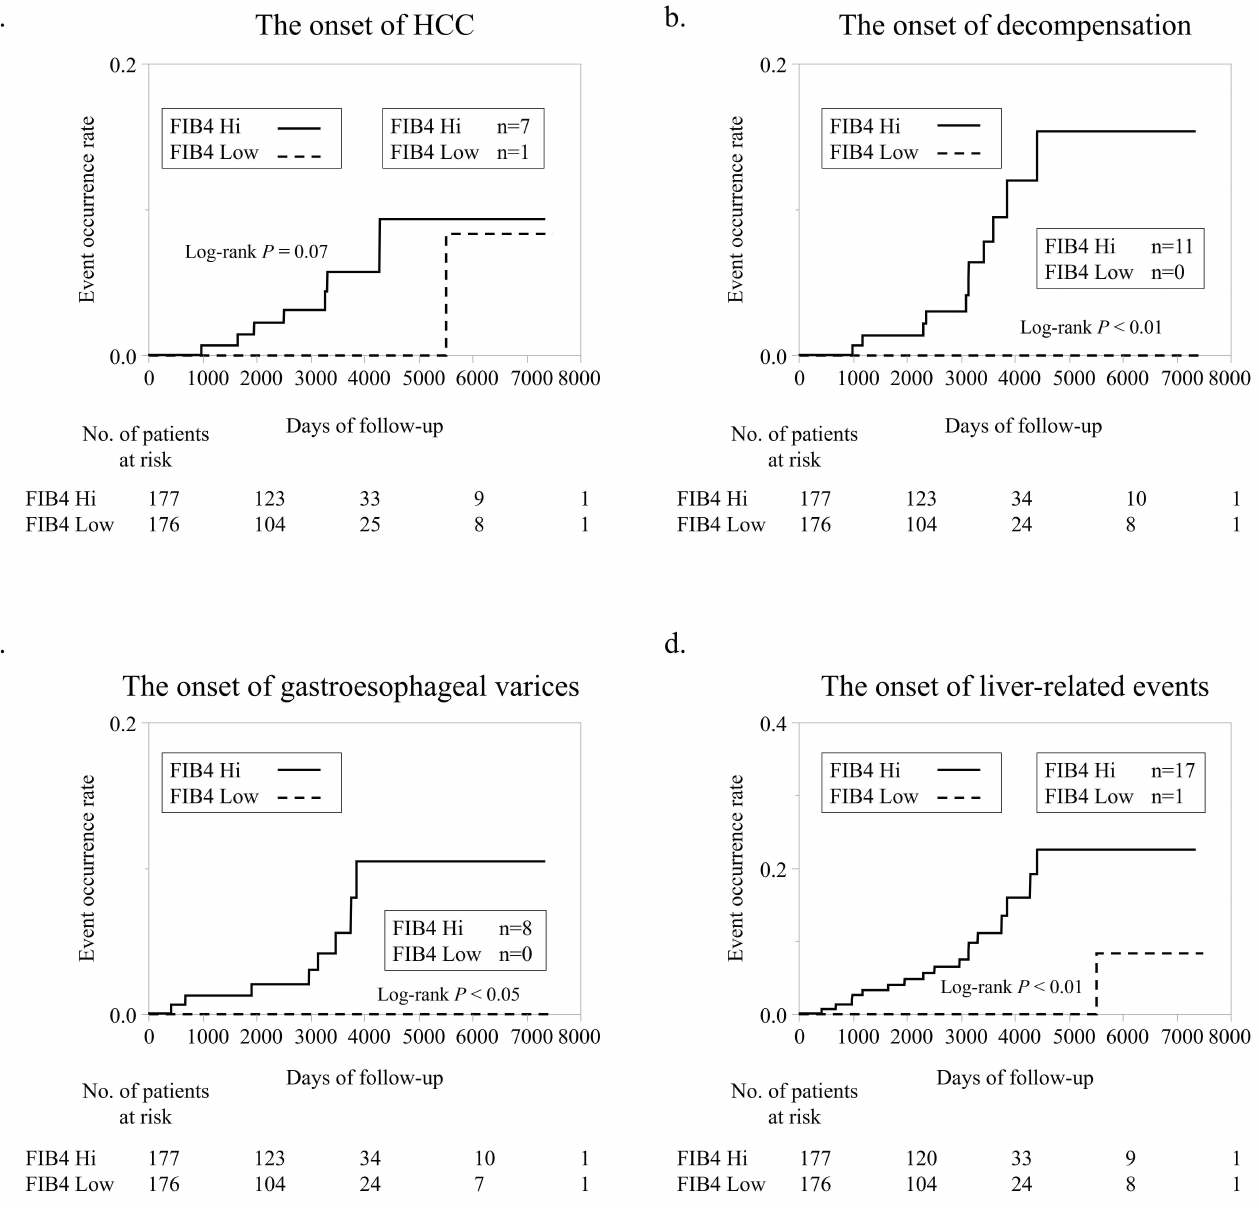
Figure 2. Liver-related event development according to FIB-4 index. ( a ). Comparison of new HCC development according to FIB-4 index. ( b ). Comparison of new decompensation development according to FIB-4 index. ( c ). Comparison of new bleeding gastroesophageal varices development according to FIB-4 index. ( d ). Comparison of LRE development according to FIB-4